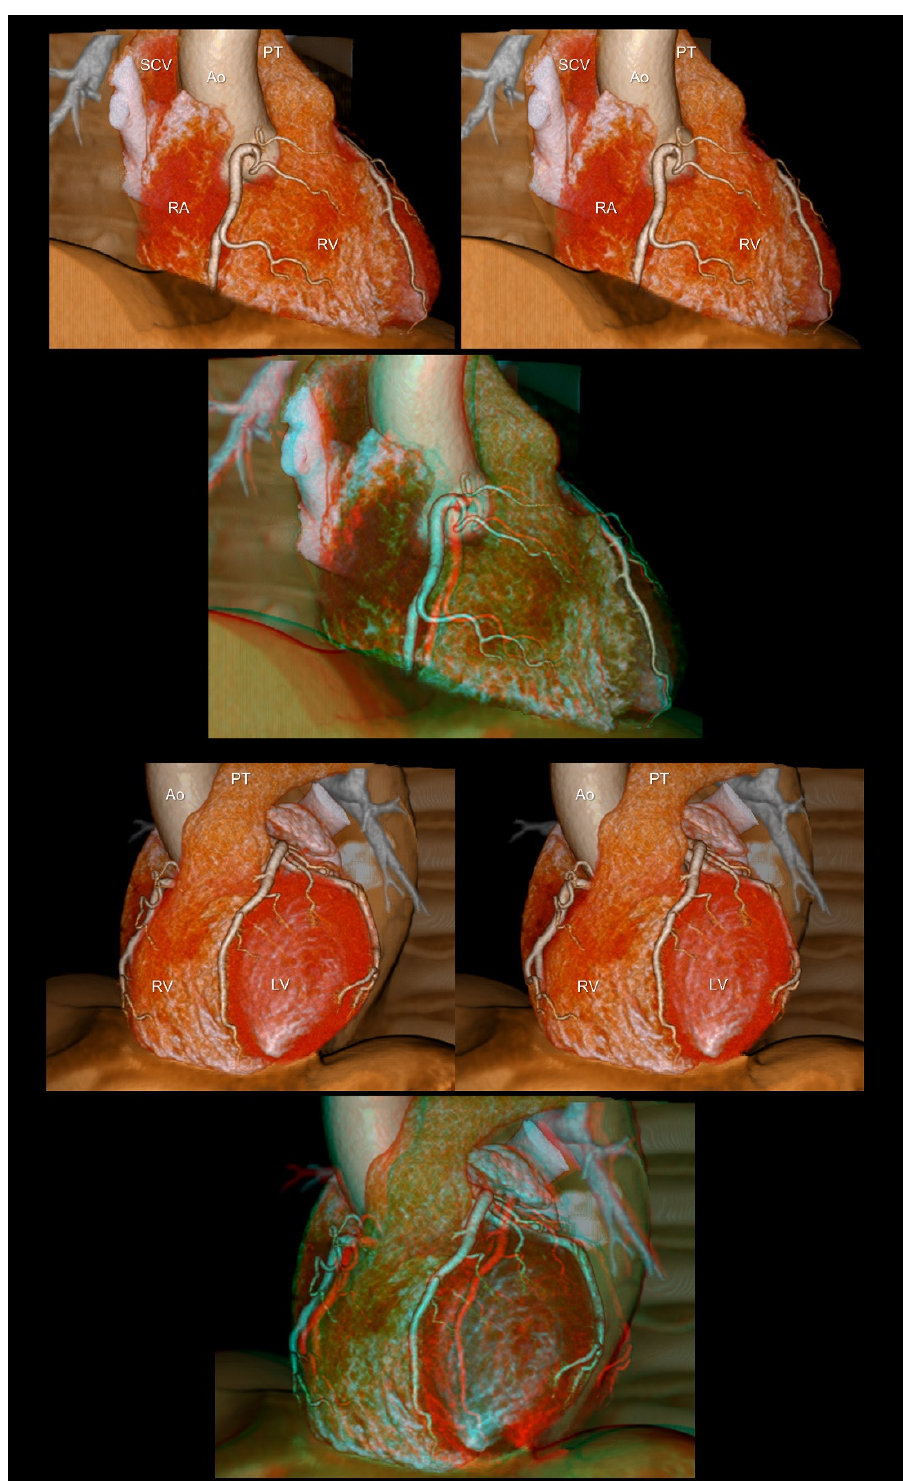
Figure 1. The right ( upper panels ) and left ( lower panels ) anterior oblique views of the heart reconstructed without epicardial adipose tissue. The first and second panels are aligned for cross ‐ eyed viewing. The third panel is the anaglyph. To see the anaglyph, anaglyphic glasses (red/cyan) are required. Ao, ascending aorta; LV, left ventricle; PT, pulmonary trunk; RA, right atrium; RV, right ventricle; SCV, superior caval vein.